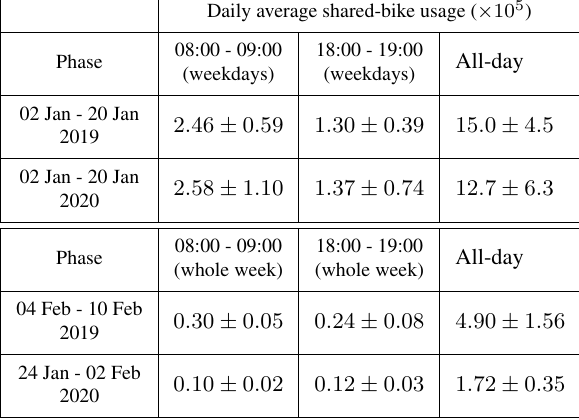
Table 2. Shared-bike usage in different time intervals, shown in form ¯ x ± 2 σ .